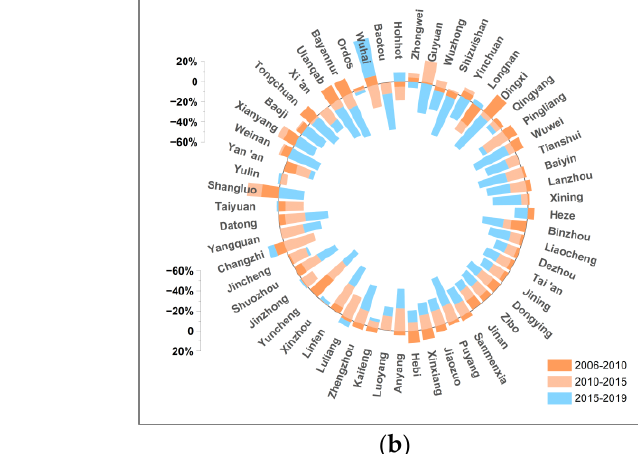
Figure 10. Contribution and contribution rate of industrial-structure factor. ( a ) Contribution of industrial-structure factor. ( b ) Contribution rate of industrial-structure factor.